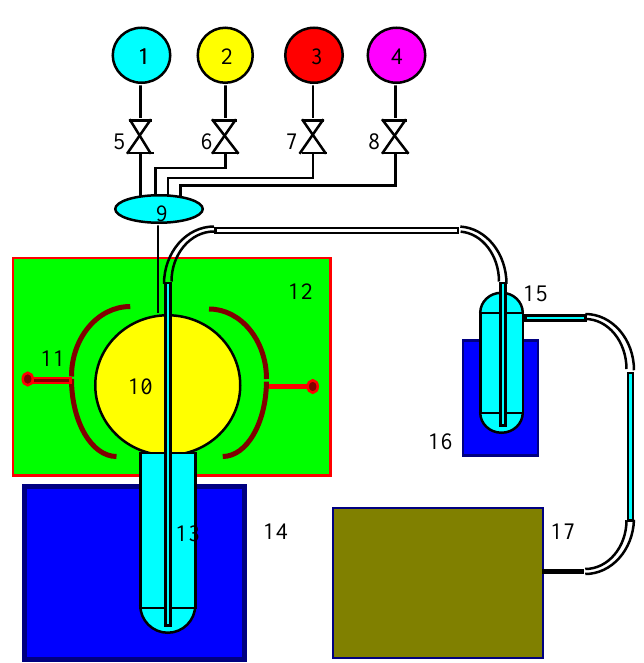
Figure 2. The installation for cold plasma synthesis. 1,2,3,4 - gas cylinders; 5,6,7,8 - valves; 9 - mixing vessel; 10 - plasma reactor; 11 - capacitive electrodes; 12 - RF plasma generator; 13 - cylindrical reactor; 14 - ultracryostat; 15 - liquid N 2 cooled trap; 16 - cryostat; 17 - vacuum